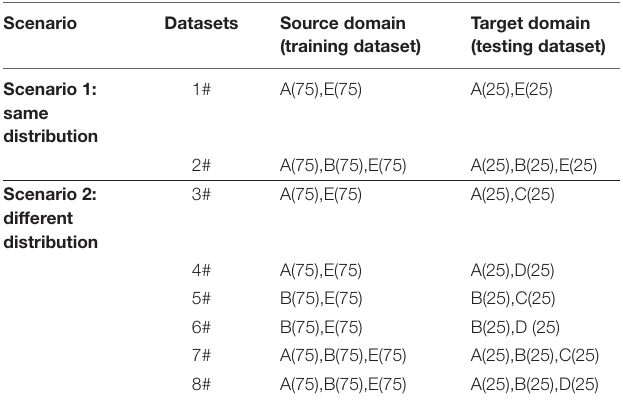
TABLE 2 | The description of the 8 groups of datasets.